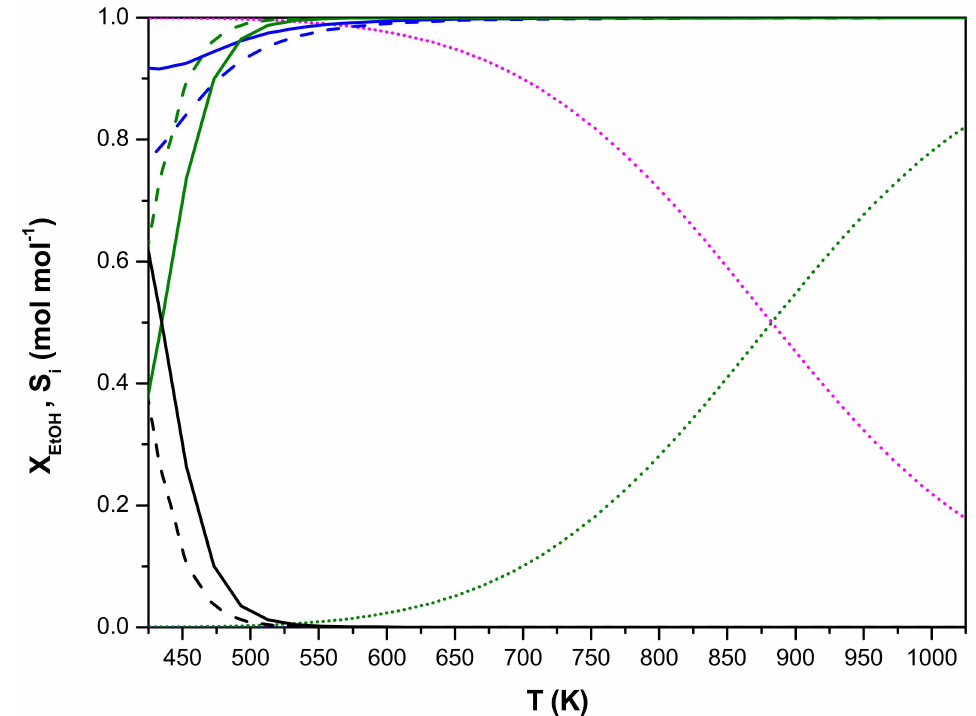
Figure 7. Thermodynamic equilibrium of ethanol conversion (blue) and selectivity towards ethene (green), di-ethyl ether (black), and 1-butene (magenta) as a function of temperature. Full line: ethanol dehydration (Equations (22)–(24)) with no additional water (case I); dashed line: ethanol dehydration (Equations (22)–(24)) with 90 mol% water (case II); dotted line: ethanol dehydration with ethene dimerization (Equations (22)–(25)) including 1-butene as a product (case